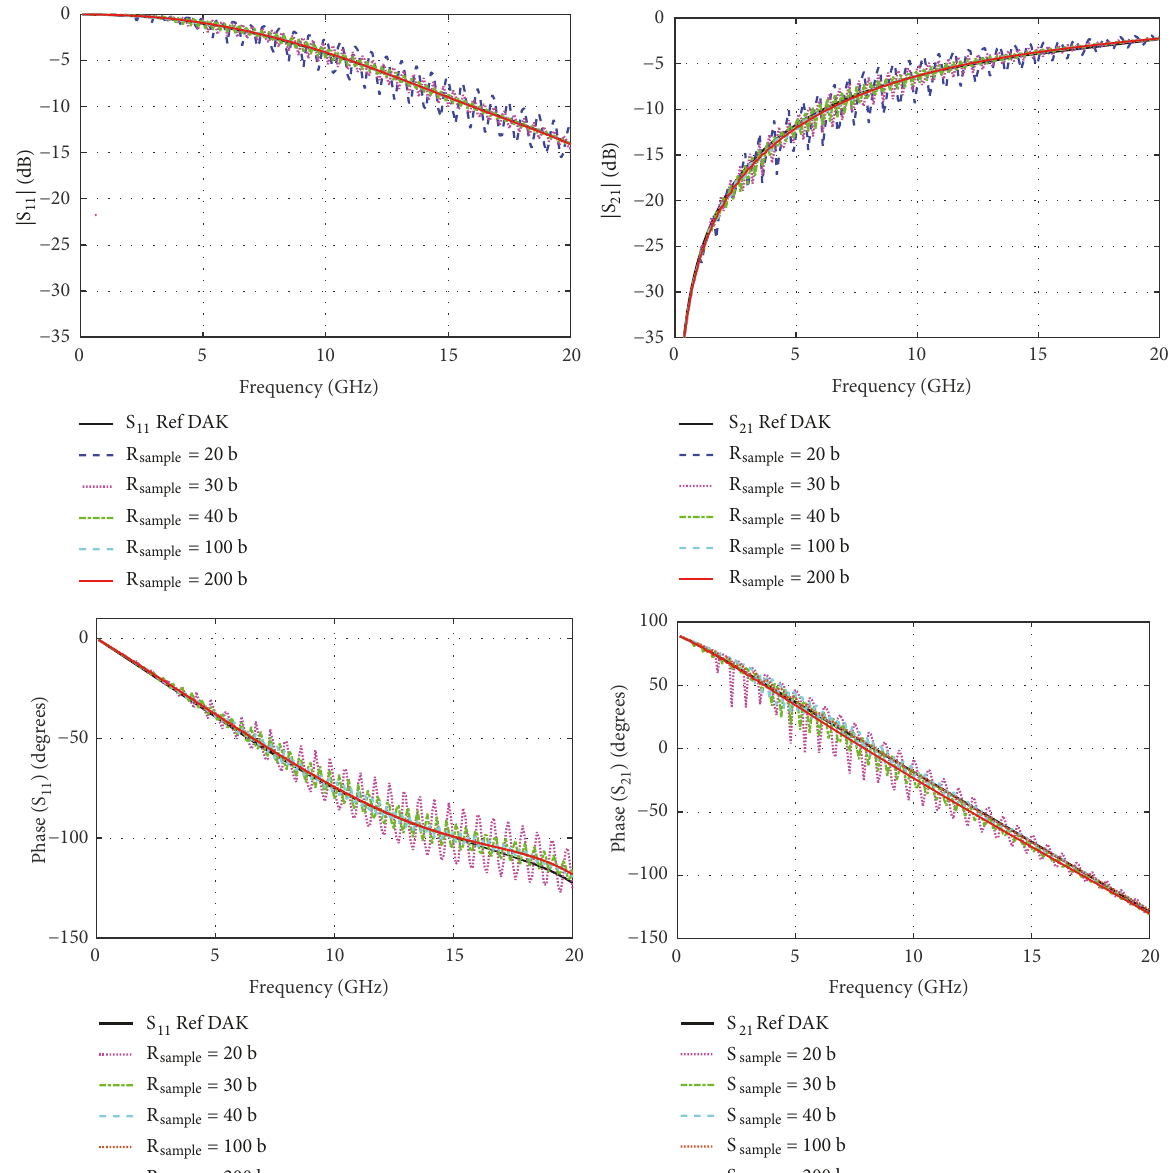
Figure 9: Magnitude (dB) and phase (degrees) of S 11 and S 21 for model A1 with TEM and TM 0 different values of the virtual circular waveguide containing the sample (thickness d